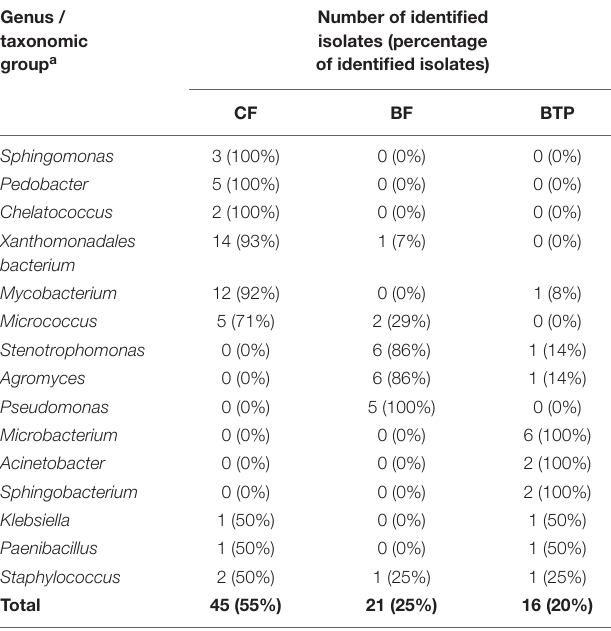
TABLE 2 | The distribution of genera of the sequenced isolates among the inoculation sources [clear filtrate (CF), biofilm (BF), and effluent from the biological treatment plant (BTP)]; only genera with more than one isolate are listed.